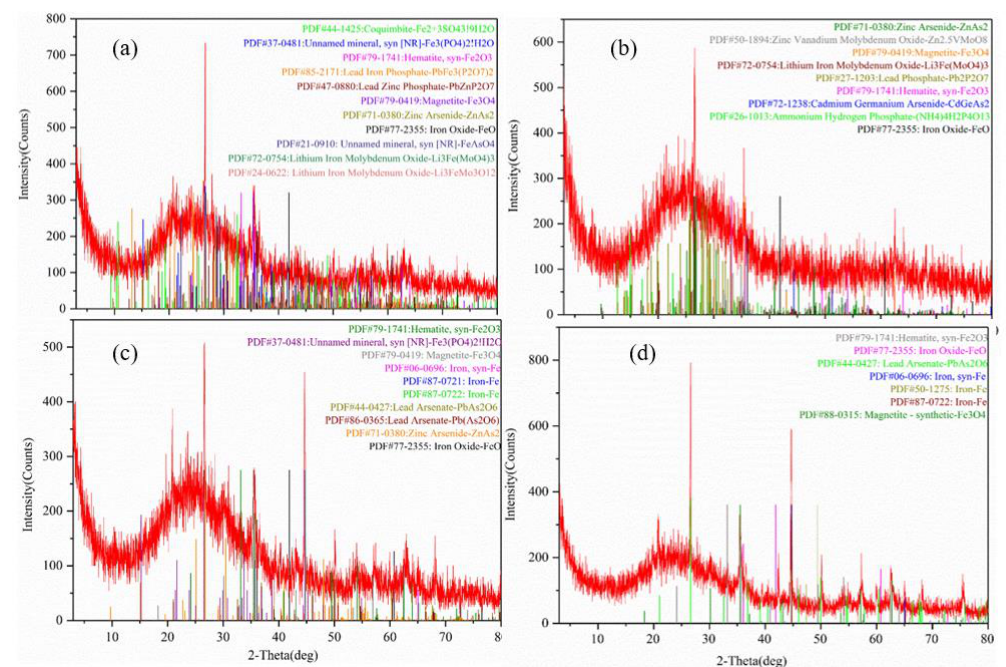
Figure 6. XRD patterns of nZVI after reaction. ( a ) 100 mg/kg S-nZVI; ( b ) 100 mg/kg S-nZVI+AM; ( c ) 100 mg/kg B-nZVI; ( d ) 100 mg/kg B-nZVI+AM.